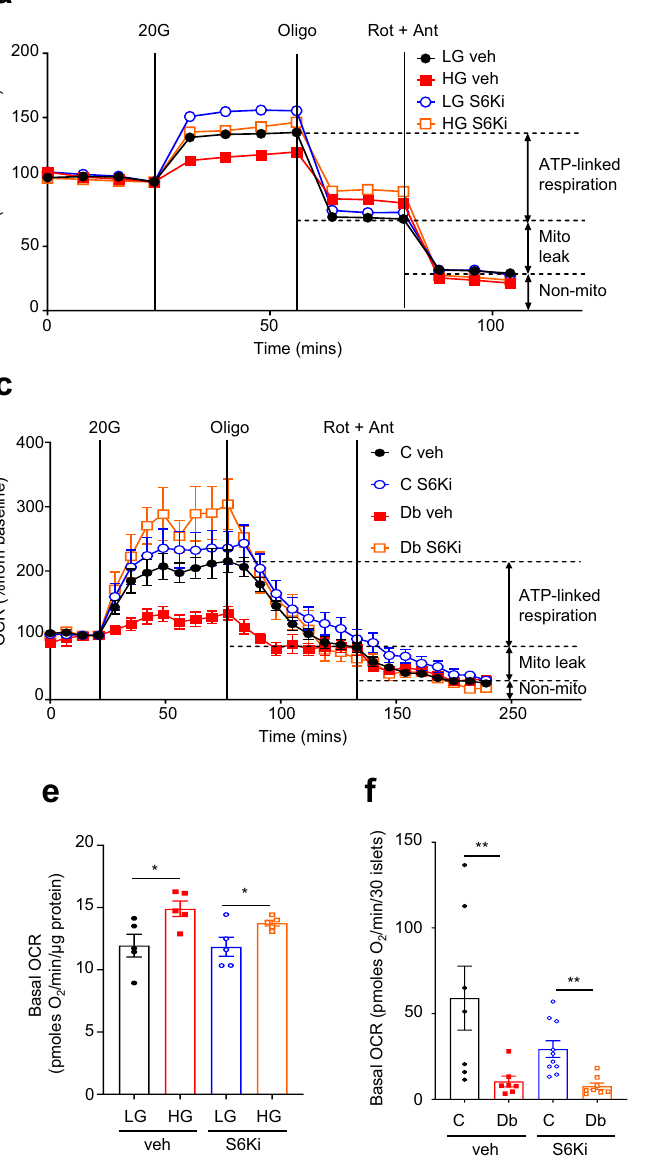
Fig. 8 | Inhibition of S6 kinase prevents the effects of chronic hyperglycaemia onoxidative metabolism.a Oxygen-consumption rate(OCR)of LG- and HG-cells cultured for 48h±10 µ M S6-kinase inhibitor PF-4708671 (S6Ki). OCR is expressed as the percentage change from the OCR baseline (2mM glucose) following sequential addition of 20mM glucose (20G), 1 μ M oligomycin (Oligo) and 0.5 μ